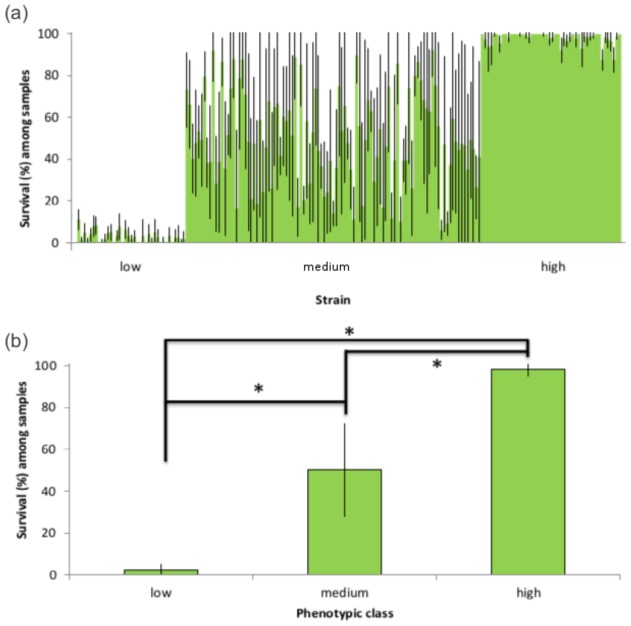
Three phenotypic classes of cold tolerance among Pristionchus pacificus samples.Mean percentage survival among samples of P. pacificus in direct cold exposure assays. (a) Each bar represents the mean of six replicate assays per sample, with error bars corresponding to standard deviation and the grouping of samples into three phenotypic classes (‘low’  =  non-cold tolerant; ‘medium’  =  cold tolerant variable; ‘high’  =  cold tolerant), as seen on the x-axis. (b) Mean survival (%) among samples is shown, grouped according to the three phenotypic classes. *Error bars correspond to standard deviation and significance.